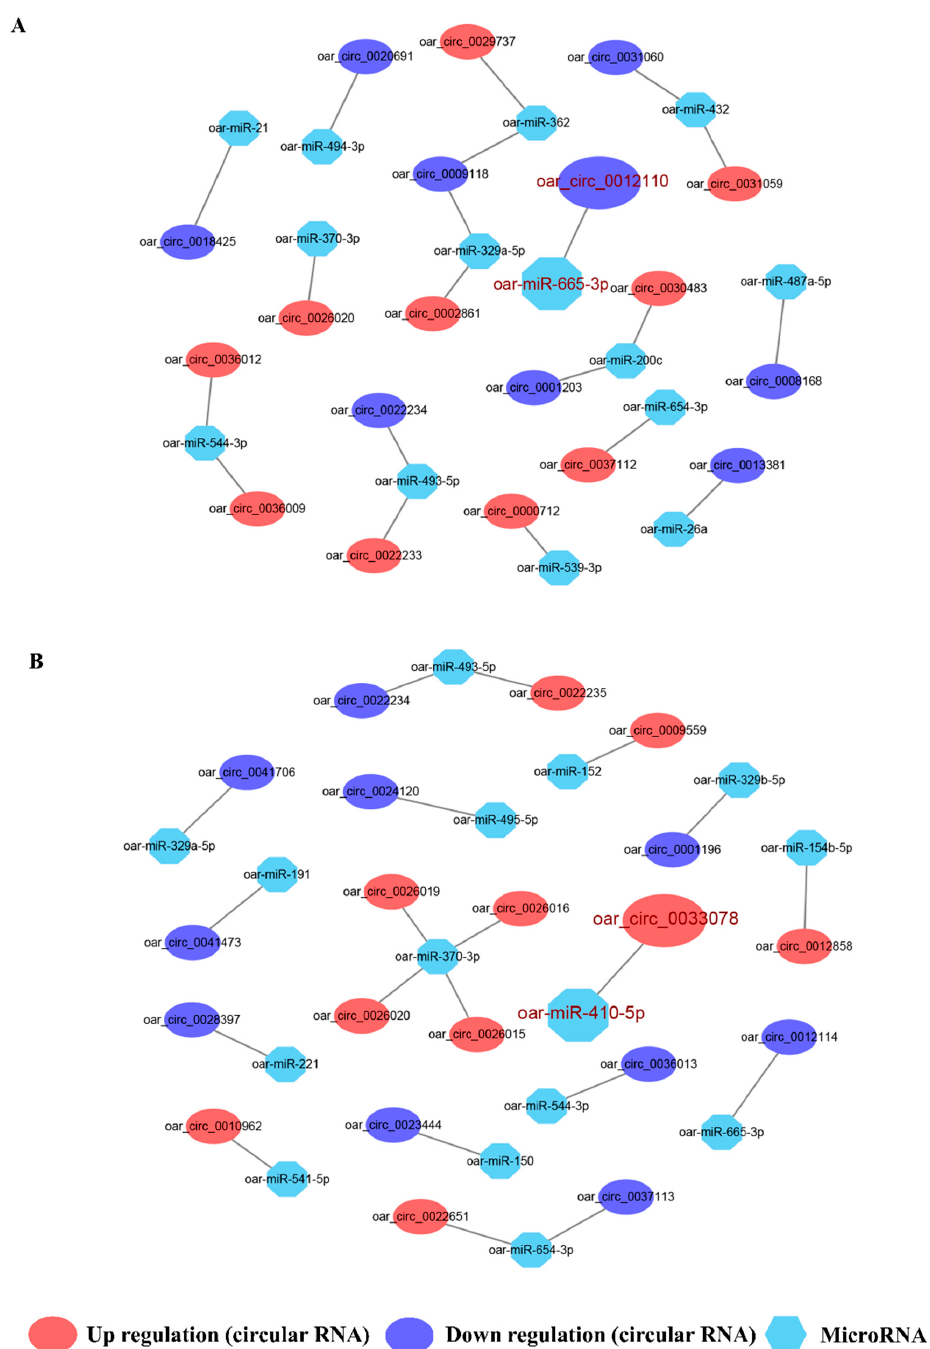
Figure 8. Prediction of microRNA-circular RNA interactive networks. ( A ) The top 20 differentially expressed circular RNAs (DE circRNAs) including the top 10 up- and 10 down-DE circRNAs in polytocous sheep in the follicular phase versus monotocous sheep in the follicular phase (PF vs. MF), in which a key circRNA-miRNA pair was highlighted in red. ( B ) The top 20 differentially expressed circular RNAs (DE circRNAs) including the top 10 up- and 10 down- DE circRNAs in polytocous sheep in the luteal phase versus monotocous sheep in the luteal phase (PL vs. ML), in which a key circRNA-miRNA pair was highlighted in red.